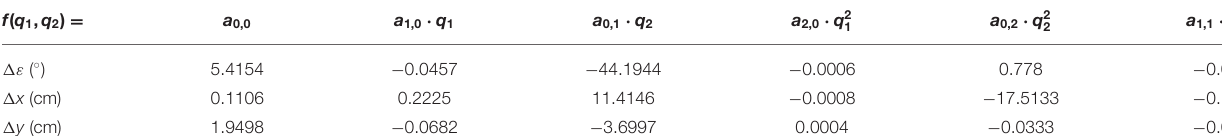
TABLE 3 | Coefficients of the bivariate polynomial fit of the motion per cycle 1 x for the experiment. f ( q 1 , q 2 ) =